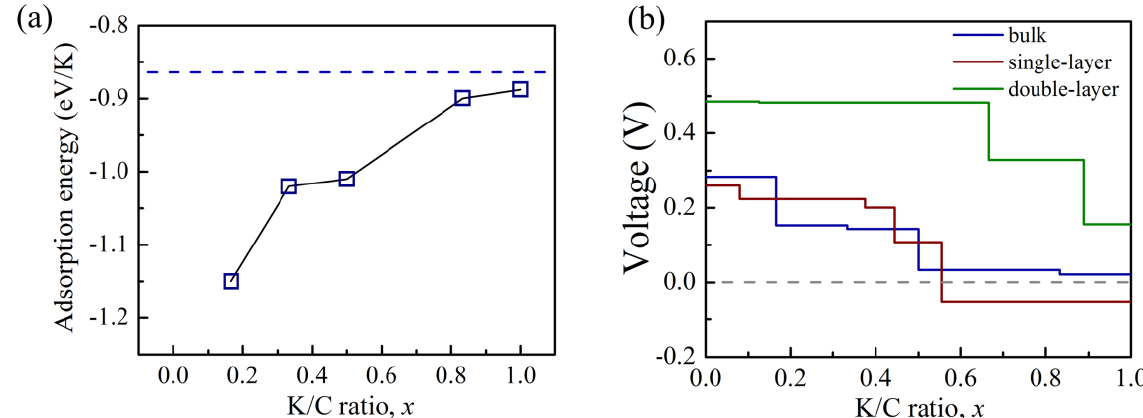
Figure 2. ( a ) The adsorption energy as a function of K concentration for bulk g-GeC and ( b ) the voltage profile of open-circuit voltage for K interaction in bulk g-GeC, one side adsorption (single-layer model) and two-surface adsorption (double-layer model) on monolayer g-GeC.